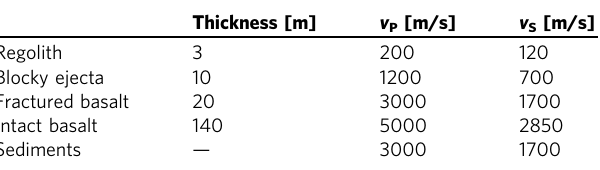
NATURE COMMUNICATIONS| (2021) 12:6756